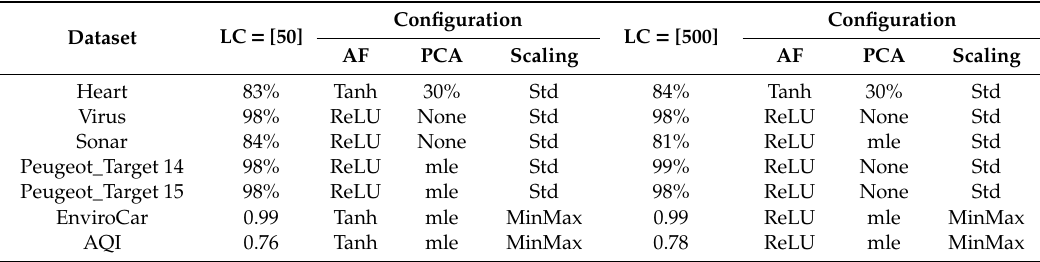
Table 27. Results for layer configuration LC = [50] and LC = [500]. We have omitted columns with all zero Dropout values.